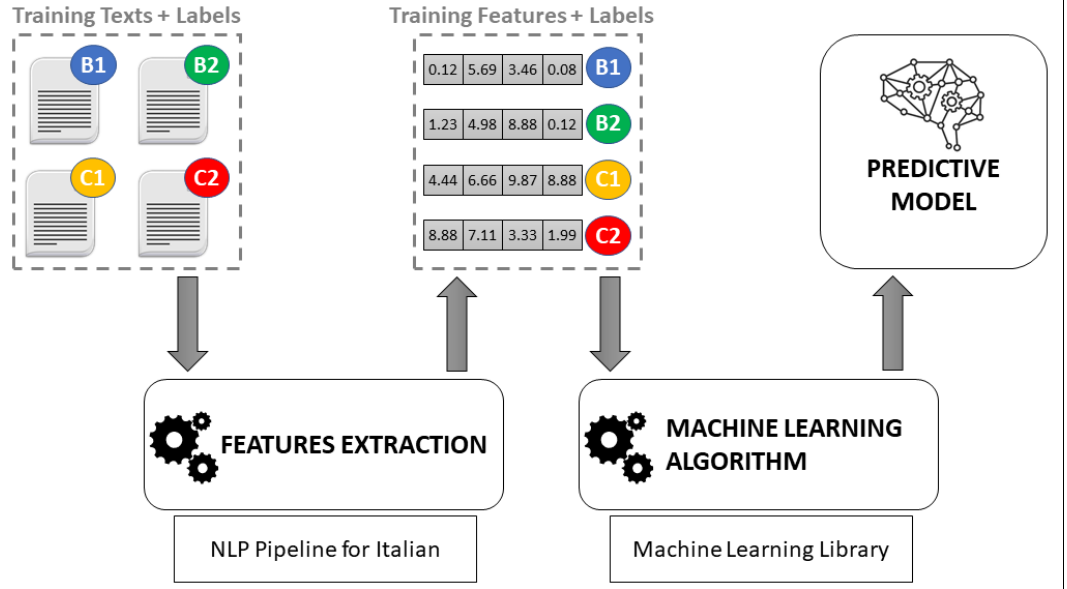
Figure 1. Training phase of the classification